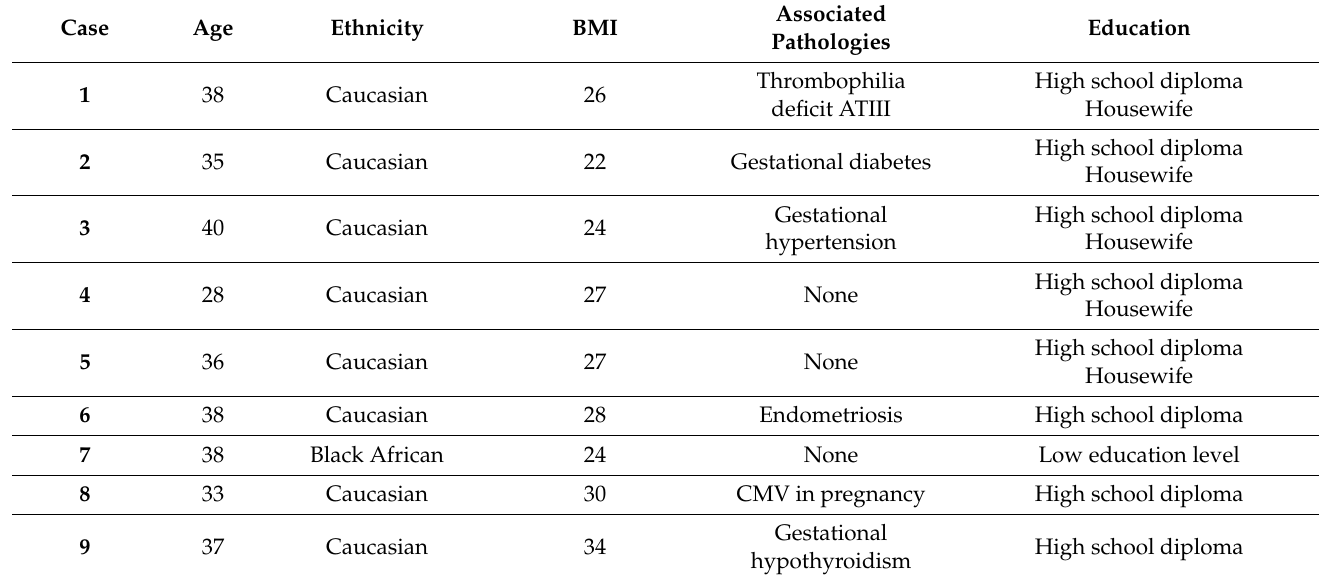
Table 1. Characteristics of